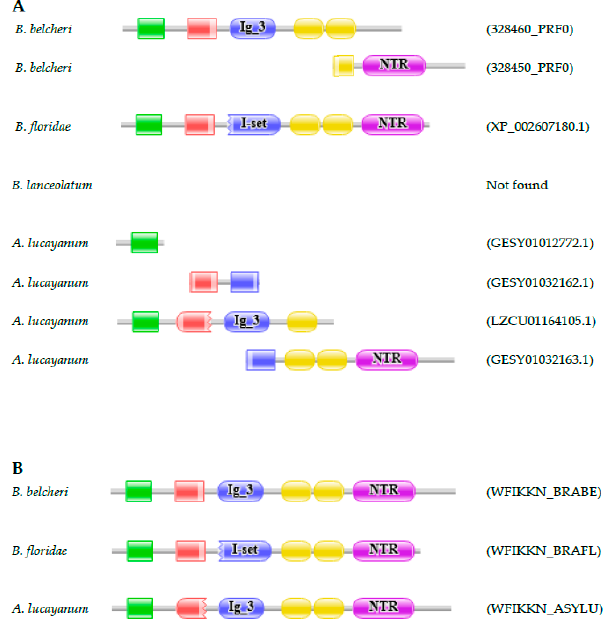
Figure 2. WAP, Follistatin, Immunoglobulin, Kunitz and NTR Domain ‐ Containing ( WFIKKN )